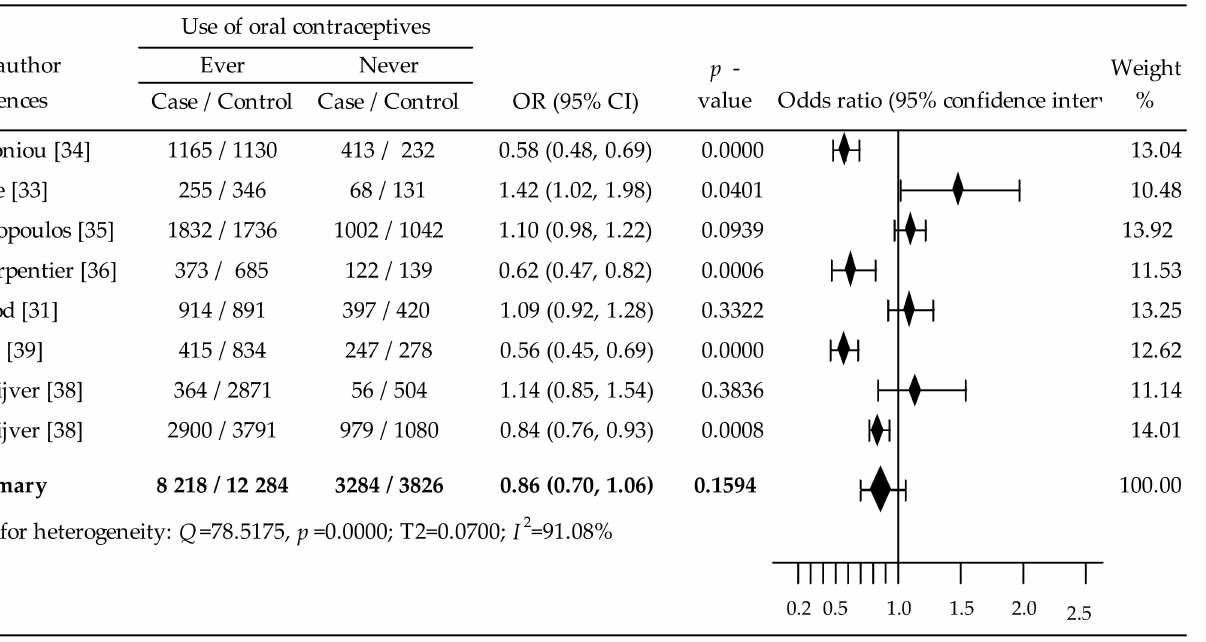
Figure 2. F Forest plots for association between oral contraceptives and breast cancer in BRCA1/2 mutation carriers [31,33–36,38,39]. Note: data are expressed as mean differences with 95% confidence intervals (CIs), using random effects models; effect is represented by the block diamond; the horizontal lines denote the 95% CIs, some of which extended beyond the limits of the